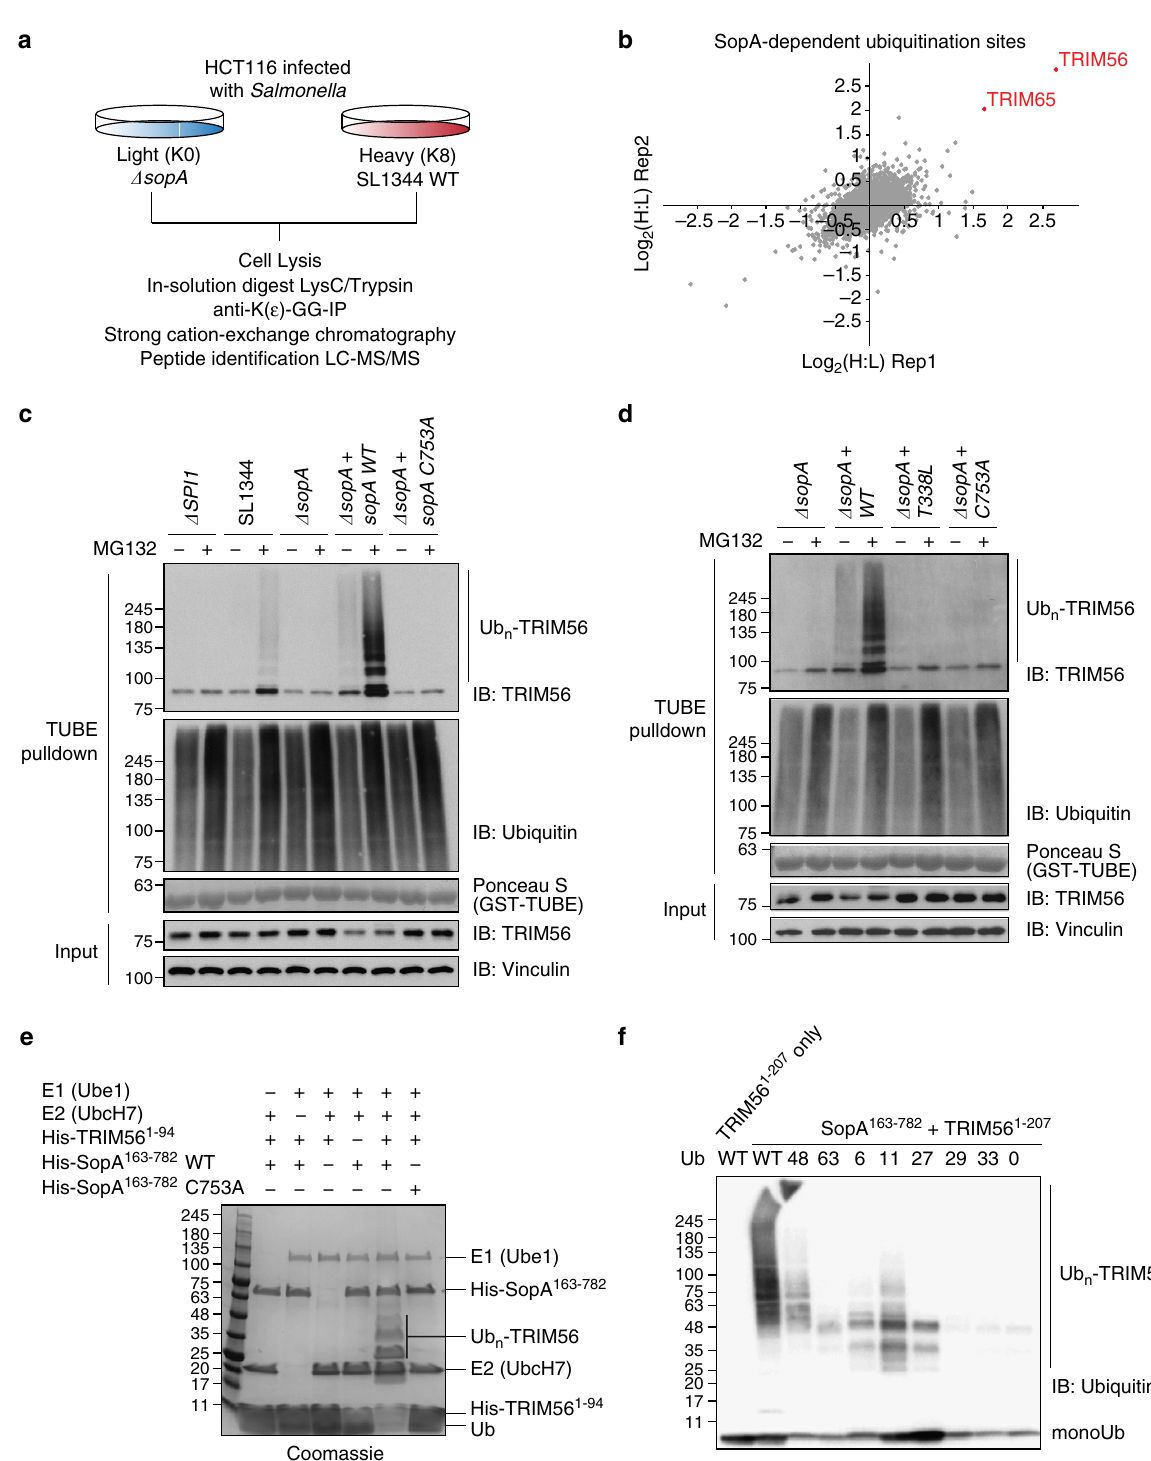
Figure 6 | TRIM56 and TRIM65 are substrates of degradative SopA ubiquitination. ( a ) Workflow for SopA-dependent ubiquitinome analysis using SILAC diGly proteomics of Salmonella SL1344 WT and D sopA -infected HCT116 cells 30min post infection. ( b ) SopA ubiquitinates TRIM56 and TRIM65. Scatter plot of replicate SopA ubiquitinome experiments. ( c , d ) SopA-mediated ubiquitination of TRIM56 on infection is MG132 sensitive and depends on SopA catalytic activity ( c ) and on SopA–TRIM56 binding ( d ). Lysates from HeLa cells infected with Salmonella SL1344 WTor indicated mutant strains in the absence or presence of 20 m M proteasome inhibitor MG132 were subjected to TUBE pulldown followed by SDS–PAGE and immunoblotting. ( e ) SopA ubiquitinates TRIM56 RING domain in vitro. Purified SopA WTand catalytic mutant (C753A) were incubated with E1, UbcH7, ubiquitin, ATP and TRIM56 RING domain. TRIM56 ubiquitination is seen with WT SopA but not in the presence of catalytic-dead SopA. ( f ) Testing SopA ubiquitin chain specificity. WT SopA was incubated with TRIM56 (1–207) and WTubiquitin or various ubiquitin mutants that contain only a single surface lysine. E1, UbcH7, ubiquitin and ATP were added to all the reactions. TRIM56 alone is not active under these conditions (lane